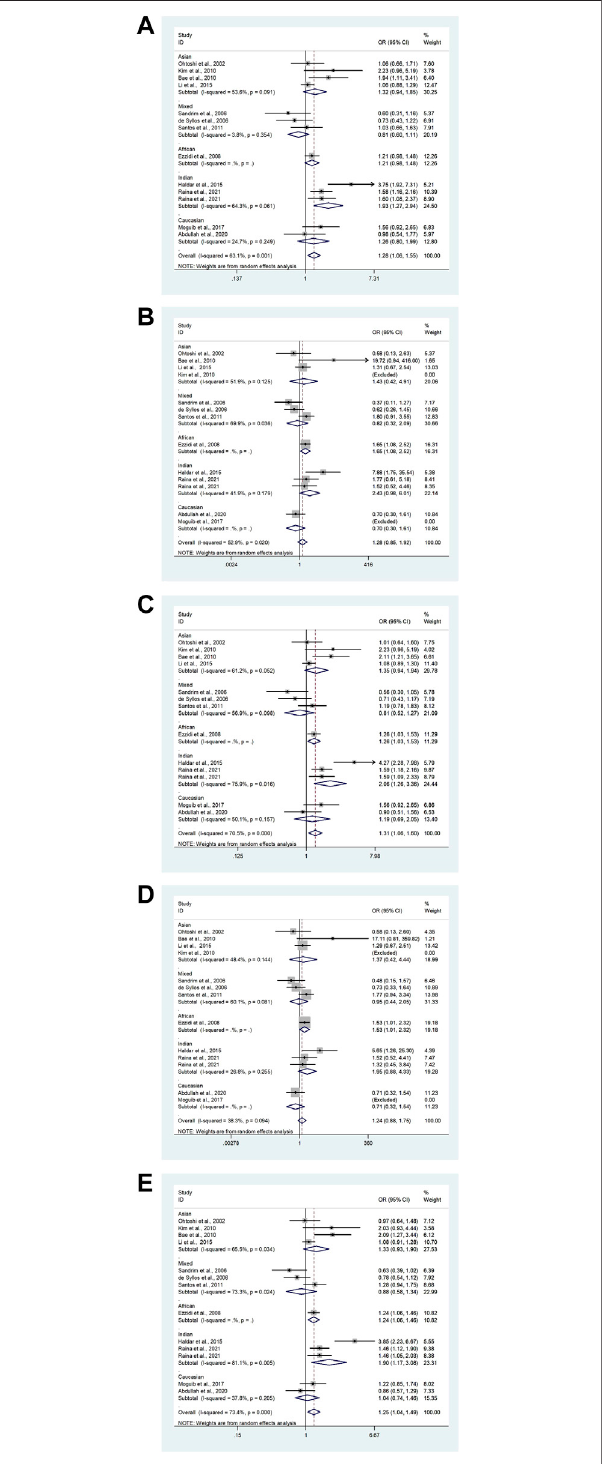
FIGURE 5 | Begg ’ s funnel plot to assess publication